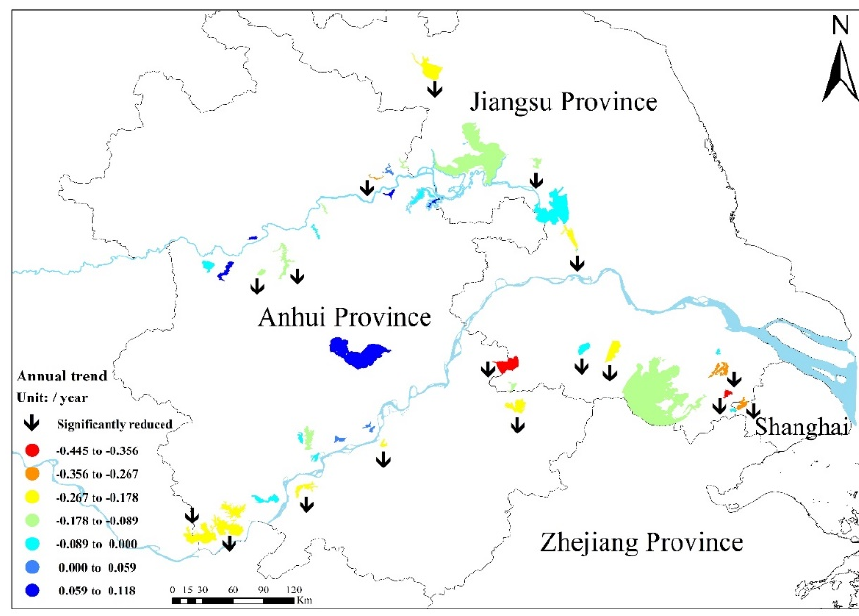
Figure 10. Interannual variation trend of TSI of lakes in the YRD area observed by MODIS.